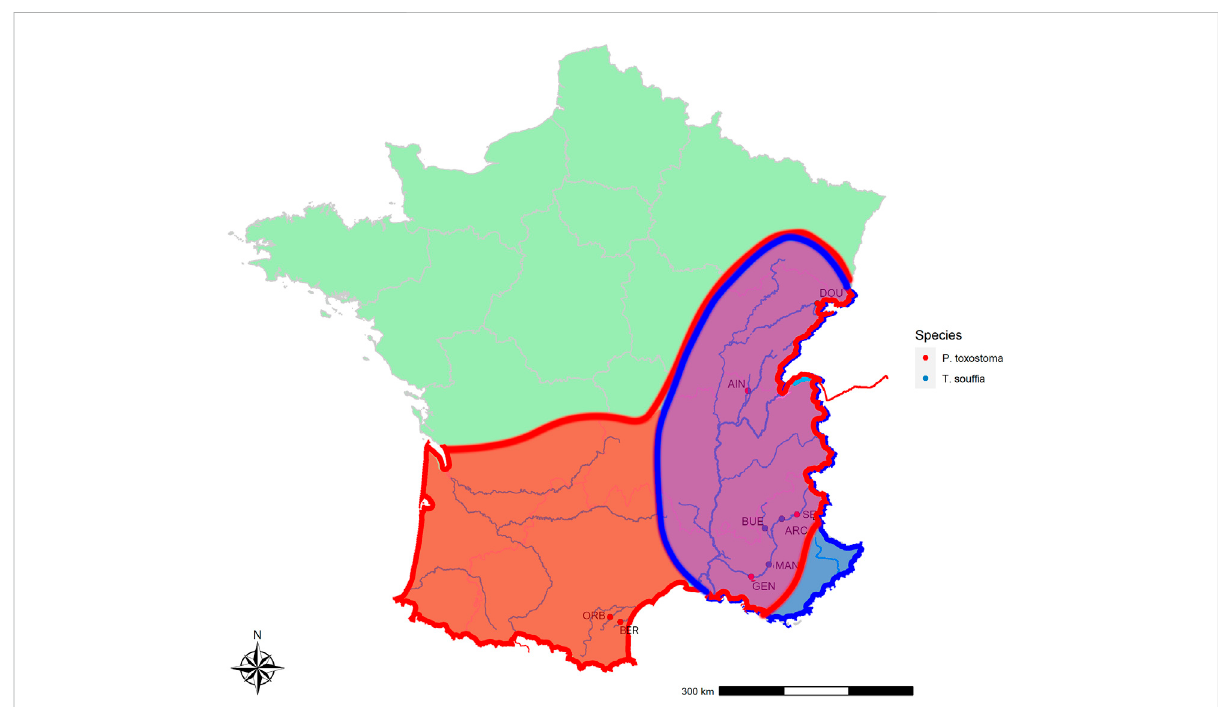
FIGURE 1 Species distribution and collection sites. In red P. toxostoma sites, in blue T. souf fi a